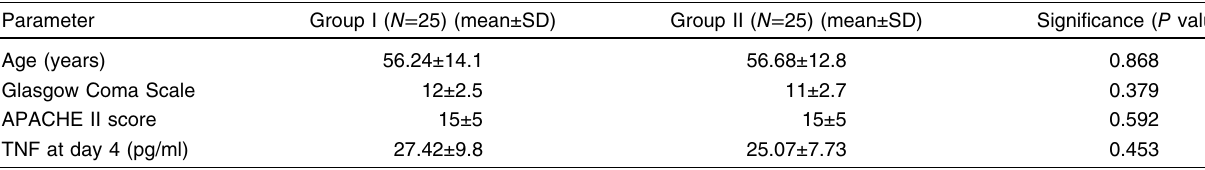
Table 1 Data collected on admission and day 4